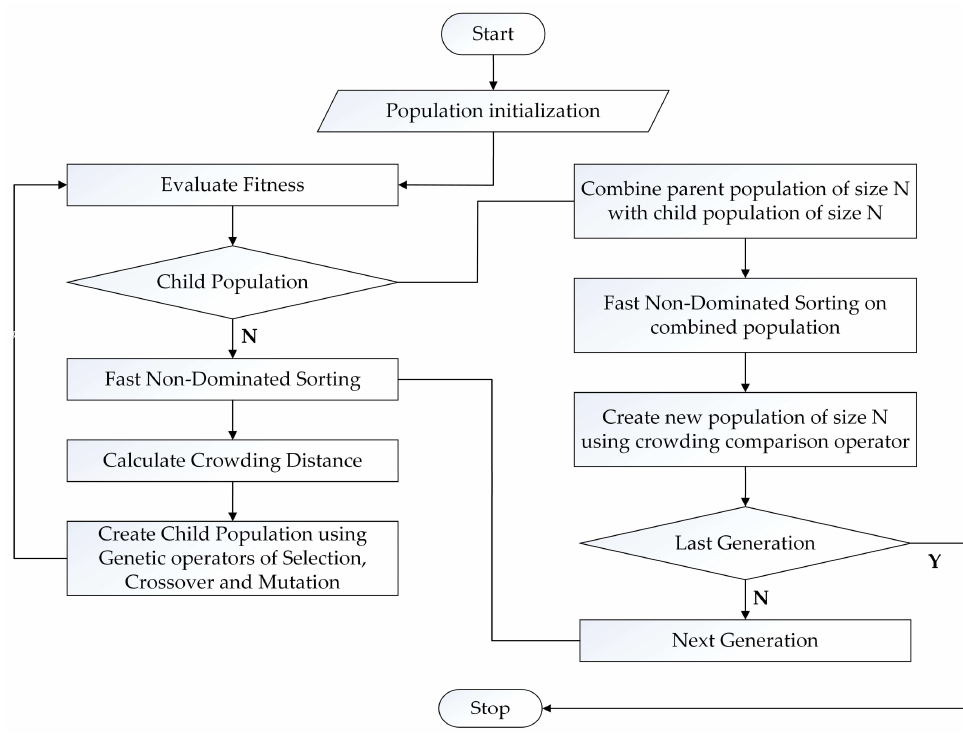
Figure 6. Flow chart of